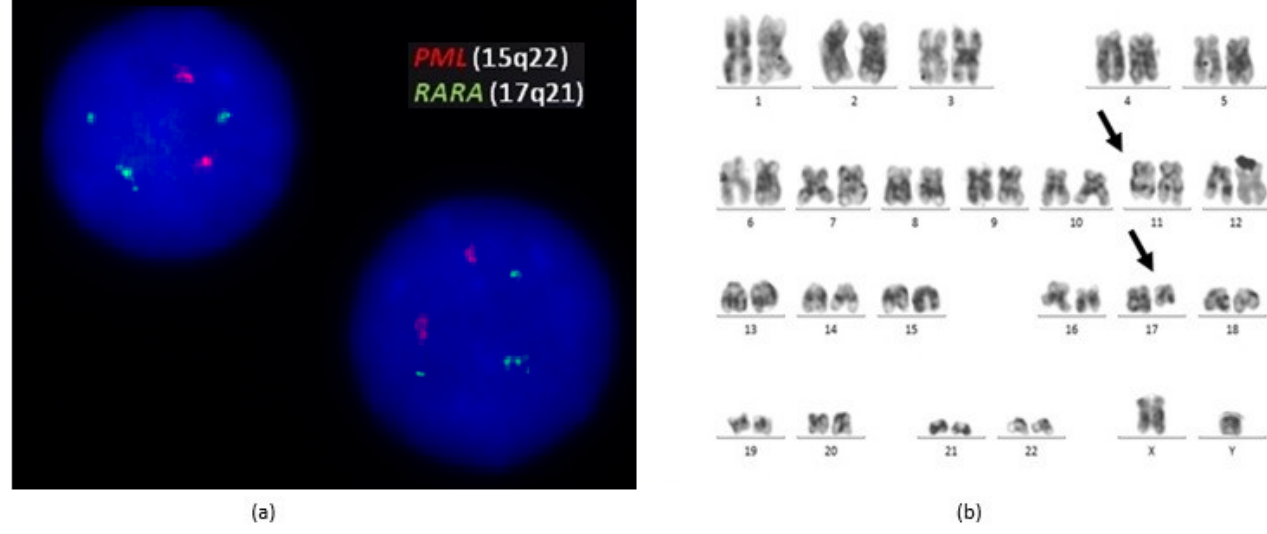
Figure 2. ( a ) FISH analysis of the patient. The Vysis probe set showed two signals on chromosome 15 (PML) and three signals on chromosome 17 (RARA), suggesting RARA rearrangement; ( b ) Karyotype analysis of the bone marrow (GTG bands):